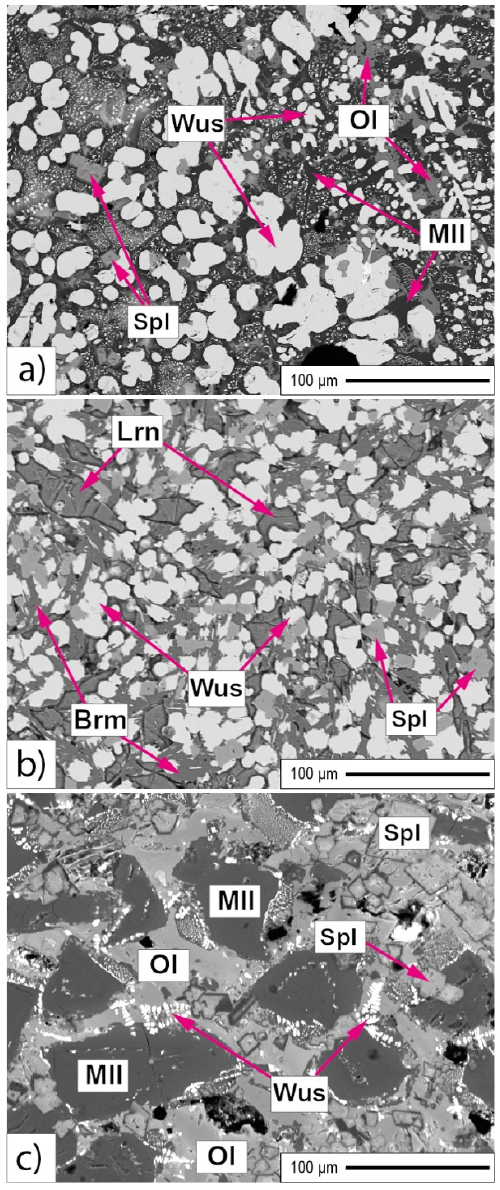
Figure 2. Back scattered electron (BSE) images. ( a ) Sample A, ( b ) Sample B, and ( c ) Sample C